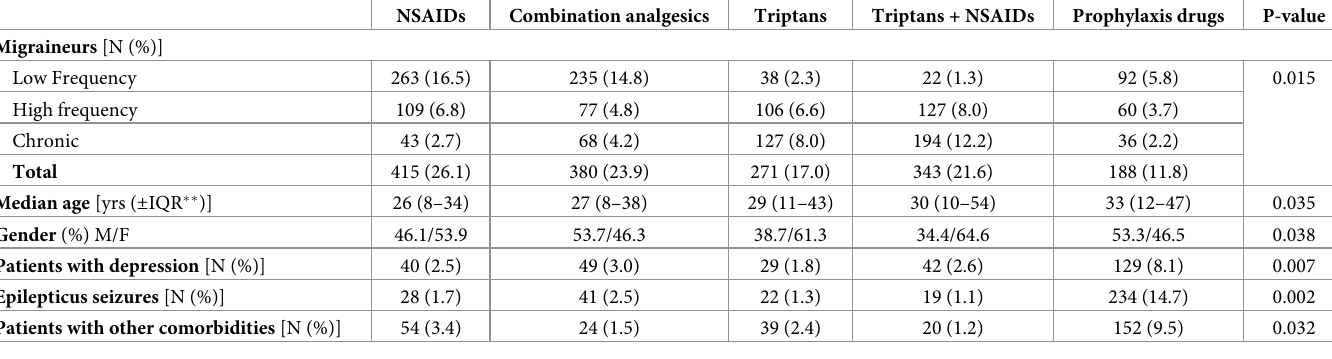
Table 2. Demographics and characteristics data of migraineurs by class of anti-migraine drugs.